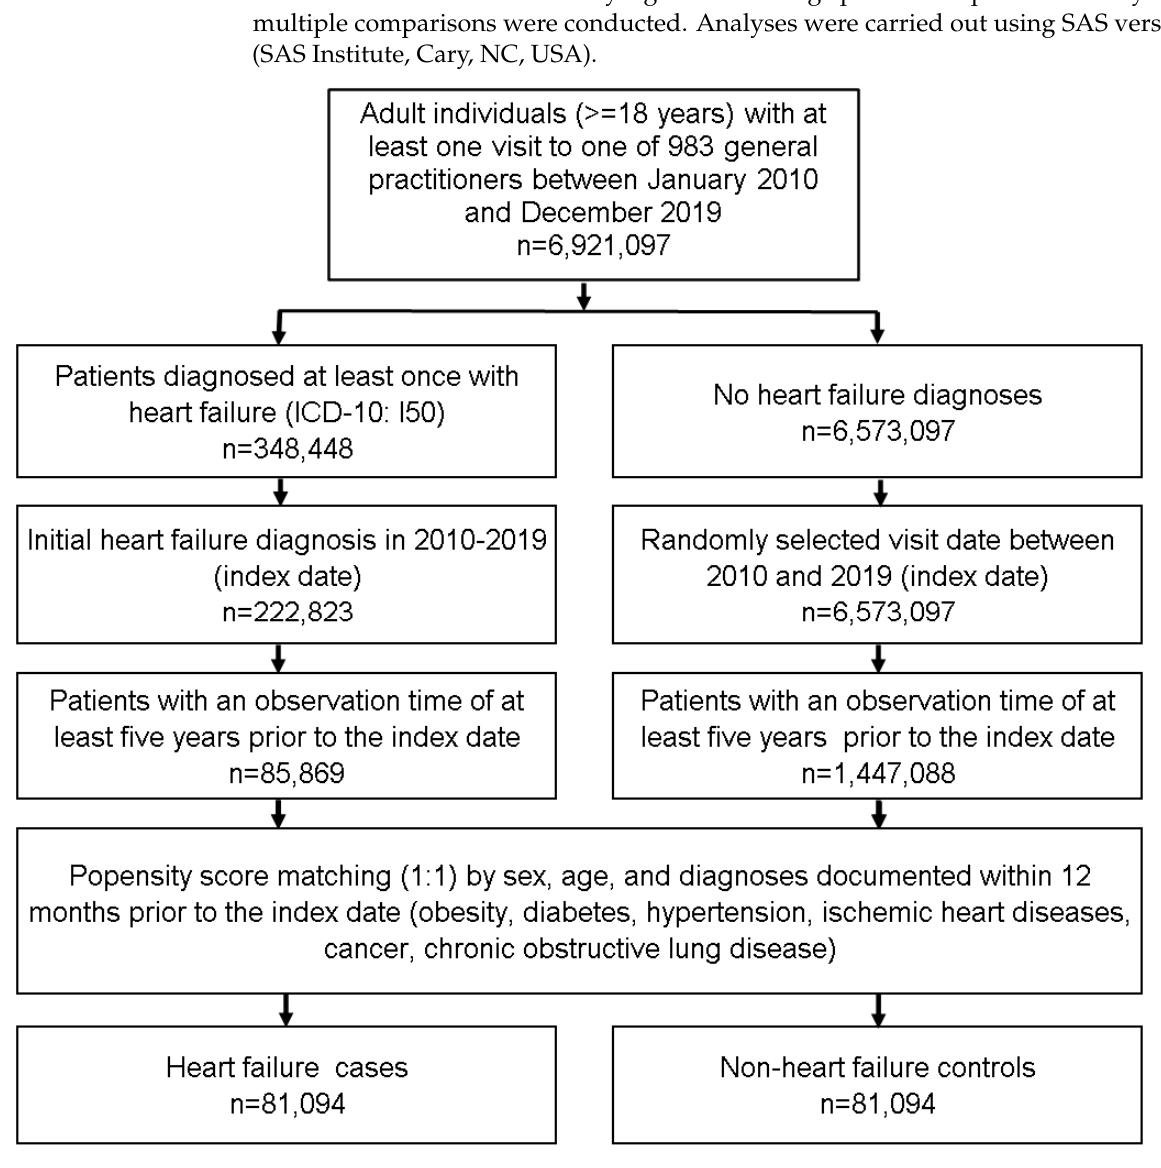
Figure 1. Selection of study patients.